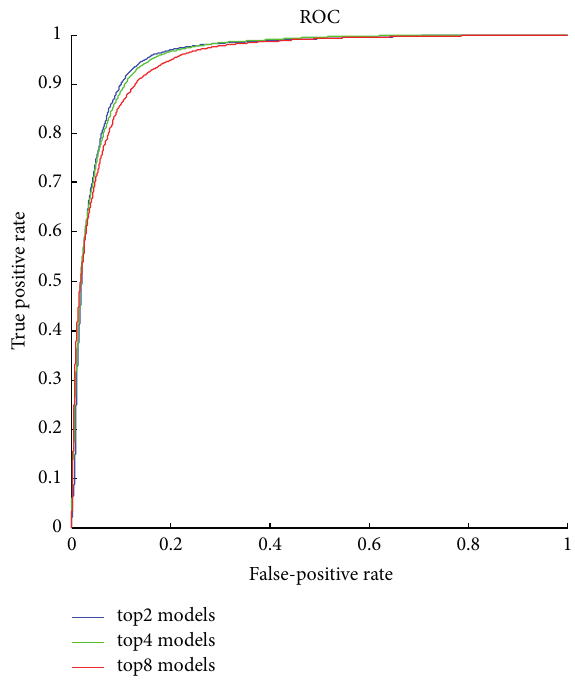
Figure 9: ROC curves for combined